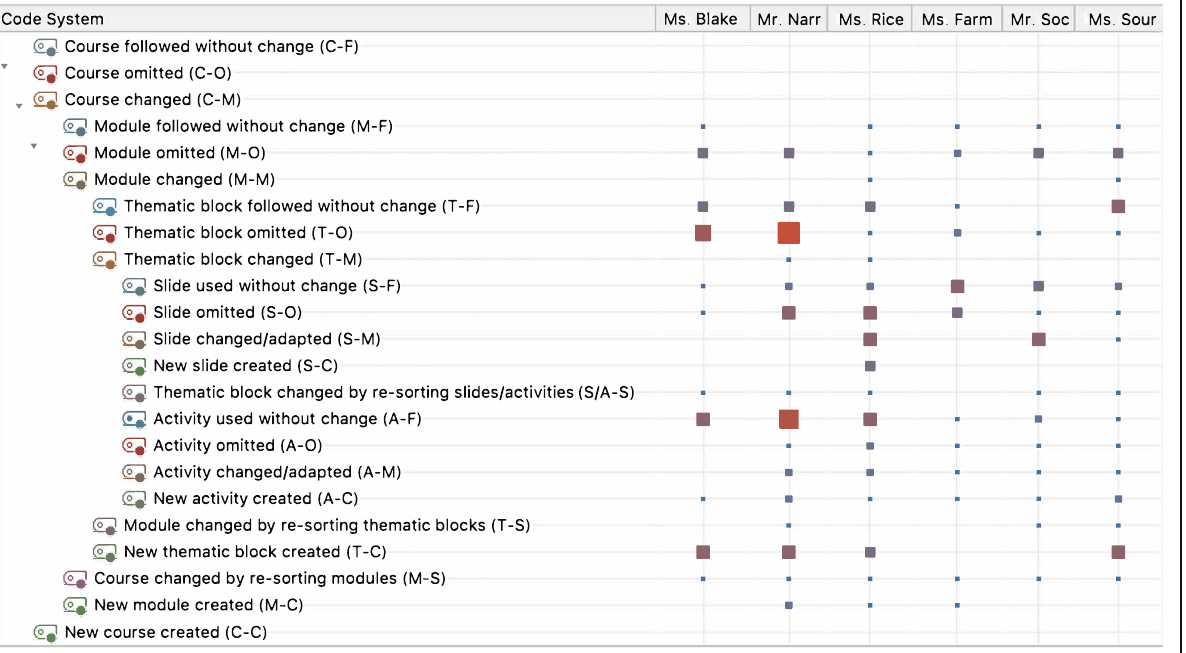
Fig. 5 Code matrix highlighting the frequency of materialized adaptation actions in six interview